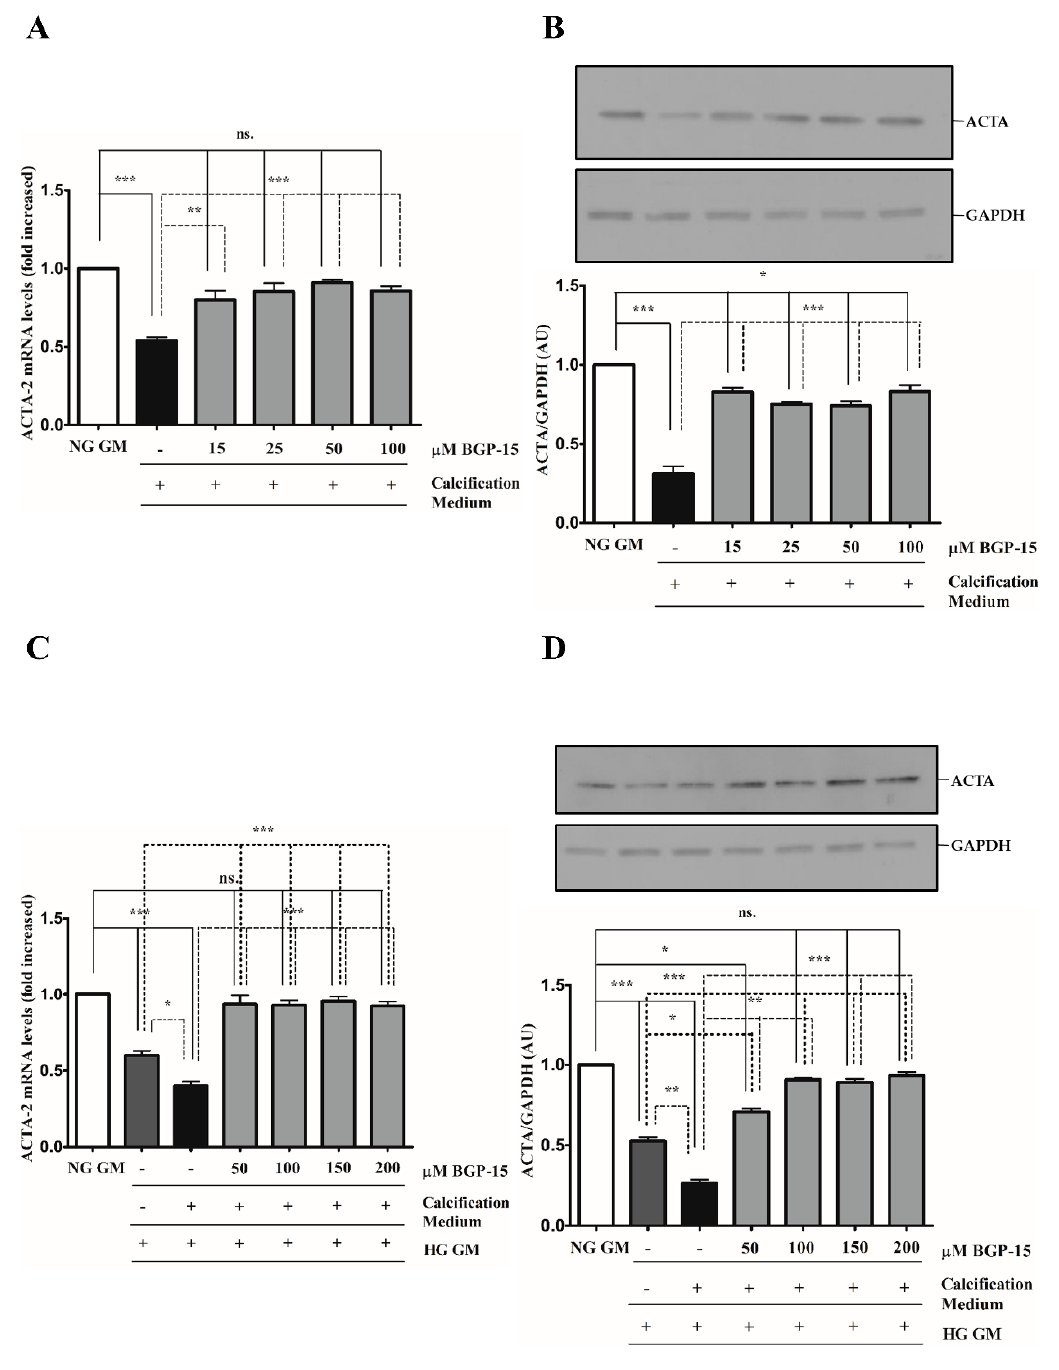
Figure 4. BGP-15 counteracts the loss of ACTA-2 induced by high Pi in NG and HG conditions. VSMCs were treated as in Figure 2. Expression of ACTA-2 was analyzed by RT-qPCR and immunoblot ( A – D ). Relative expression of ACTA-2 mRNA ( A ) and protein ( B ) in NG and HG (( C ): mRNA; ( D ): protein) conditions are shown as mean ± SEM of three independent experiments. Relative mRNA expression was normalized to RNA45S5, while protein expression to GAPDH. Statistical analysis was performed by the one-way ANOVA test followed by Bonferroni correction. A value of p < 0.05 was considered significant. * p < 0.05, ** p < 0.01, *** p <